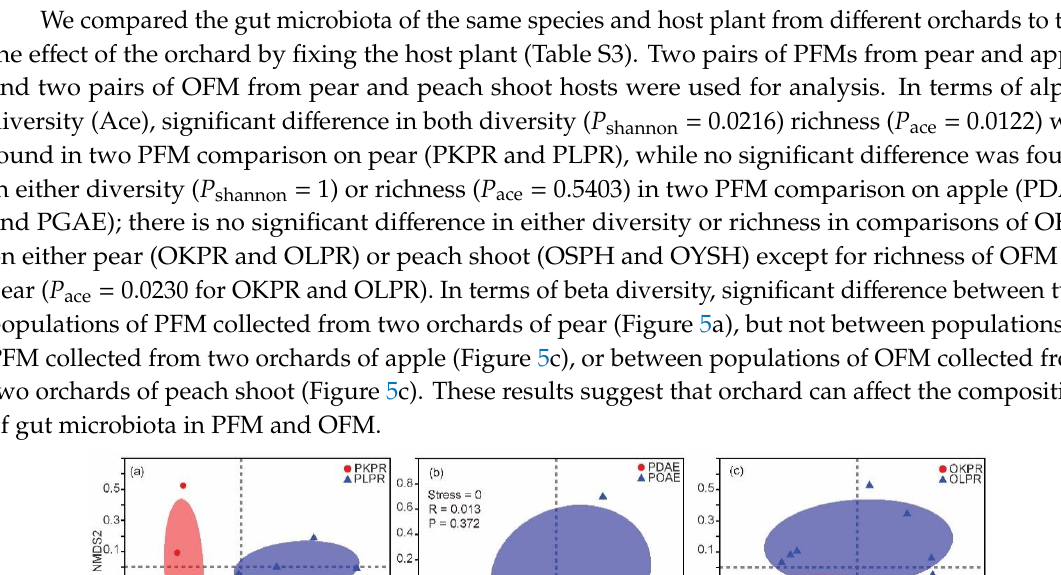
Figure 4. Comparison of gut bacterial microbiota between the peach fruit moth (PFM) Carposina sasakii and the oriental fruit moth (OFM) Grapholita molesta on apple ( a ) and pear ( b ). Value of the stress is less than 0.2 in both comparisons, indicates that the data can be represented by the two-dimensional dot diagram of NMDS. R is < 1, indicating that there is no significant di ff erence between and within groups. p value is > 0.05, indicates there is no significant di ff erence between PFM and OFM on either on apple or on pear.